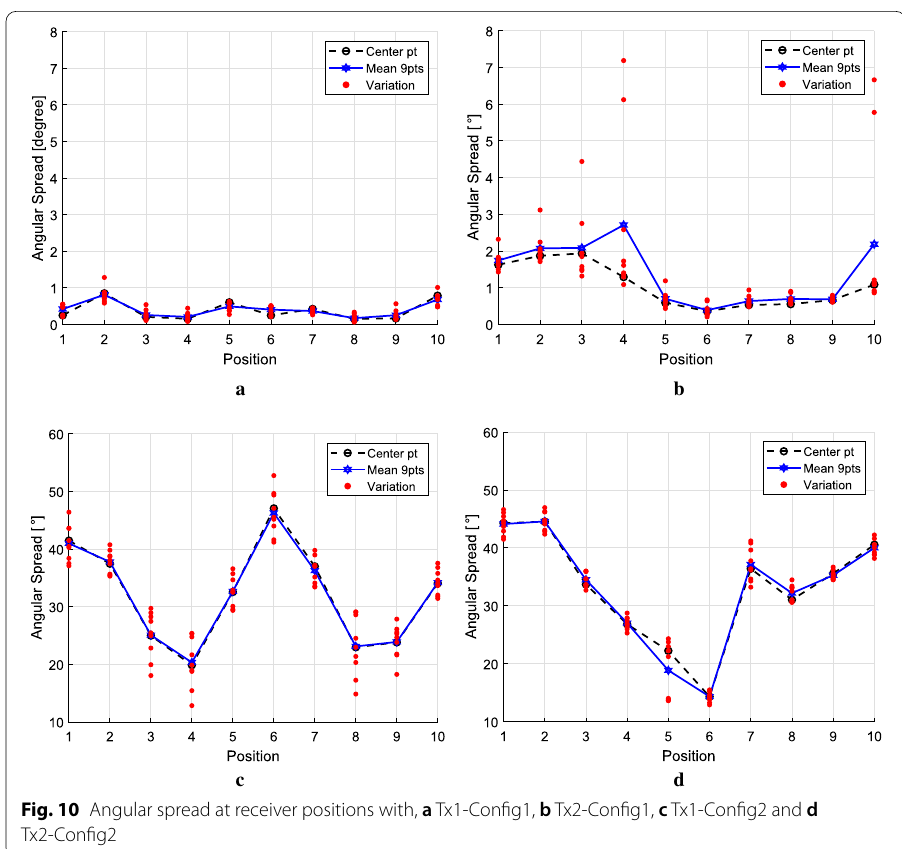
Fig. 10 Angular spread at receiver positions with, a Tx1-Config1, b Tx2-Config1, c Tx1-Config2 and d Tx2-Config2